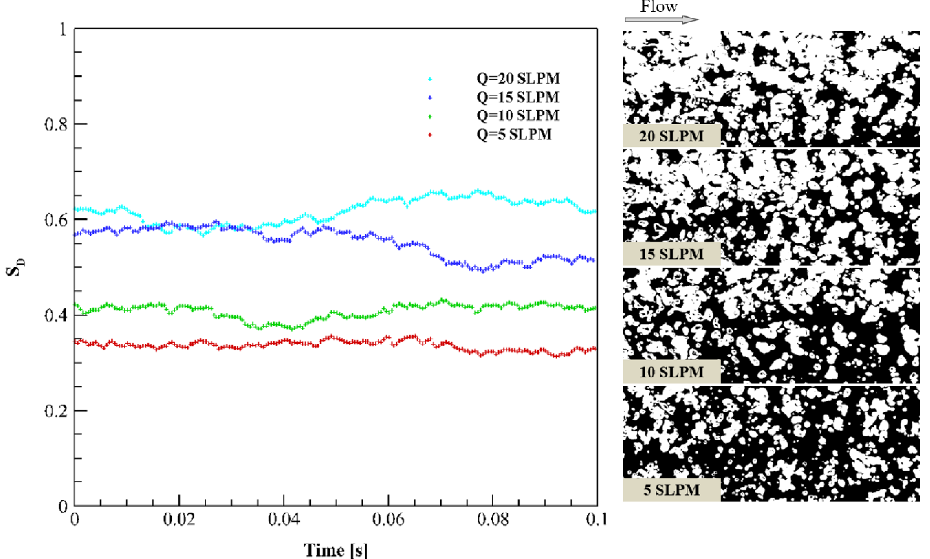
Figure 12. Change of spatial density with time at the free-stream velocity of 5 m/s for various air injection rates. The arrow indicates the direction of the free-stream velocity vector.